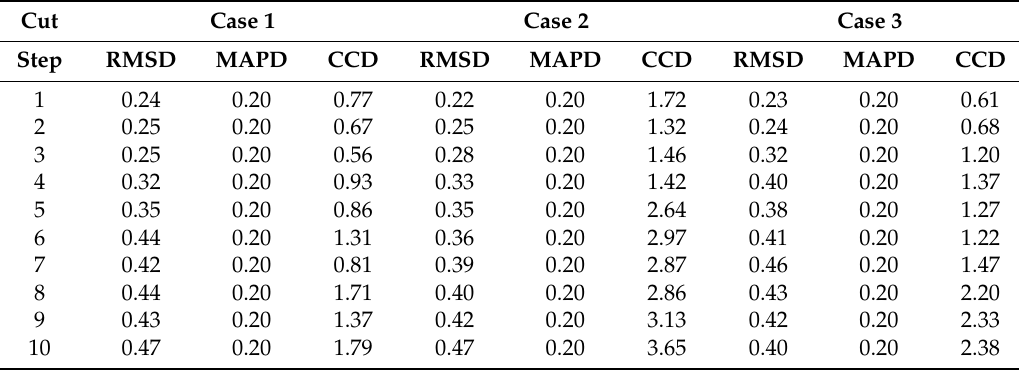
Table 2. RMSD, MAPD and CCD values (%) calculated for steel wire PZT attachment method. Cut Case 1 Case 2 Case